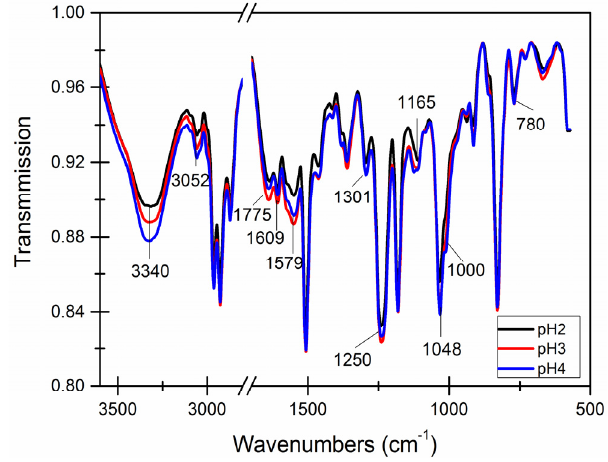
Figure 12. Infrared spectroscopy of microcapsules with different pH values.